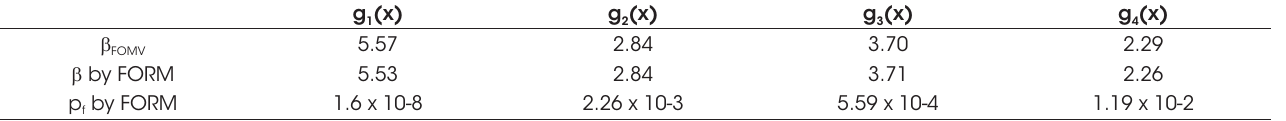
Annual serviceability reliability indices for the four limit state